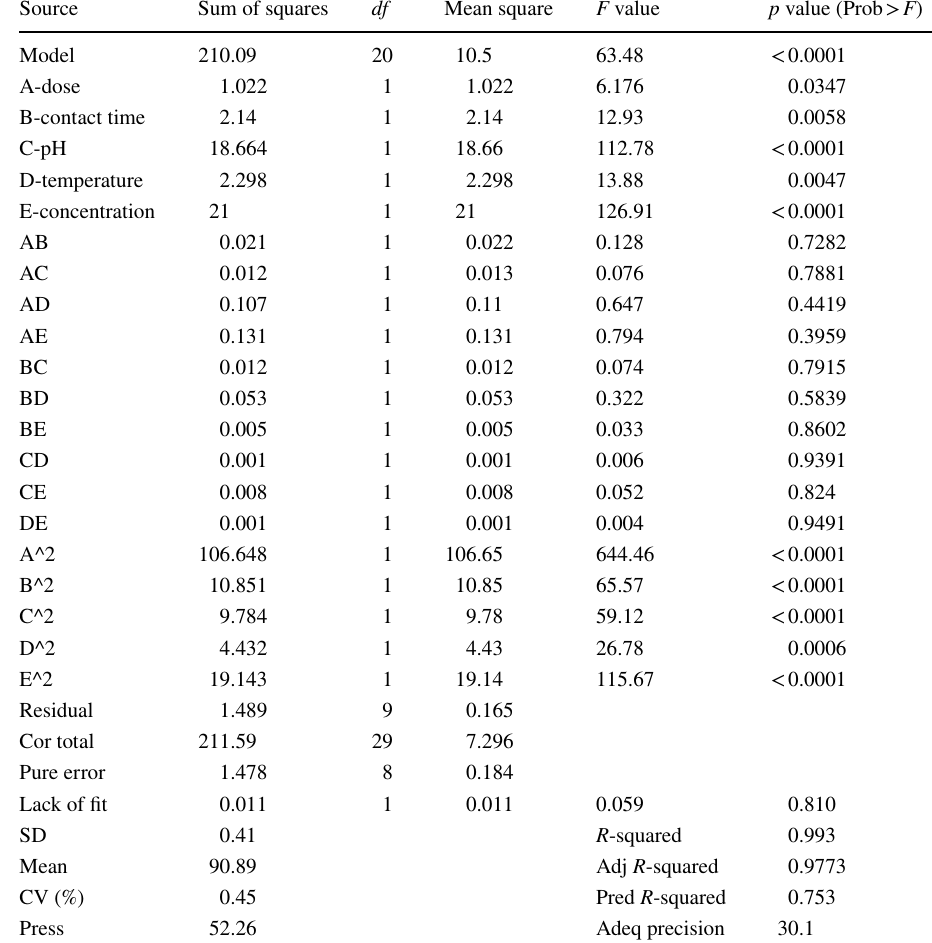
Table 5 Analysis of variance for the response of the adsorption capacity for glyphosate